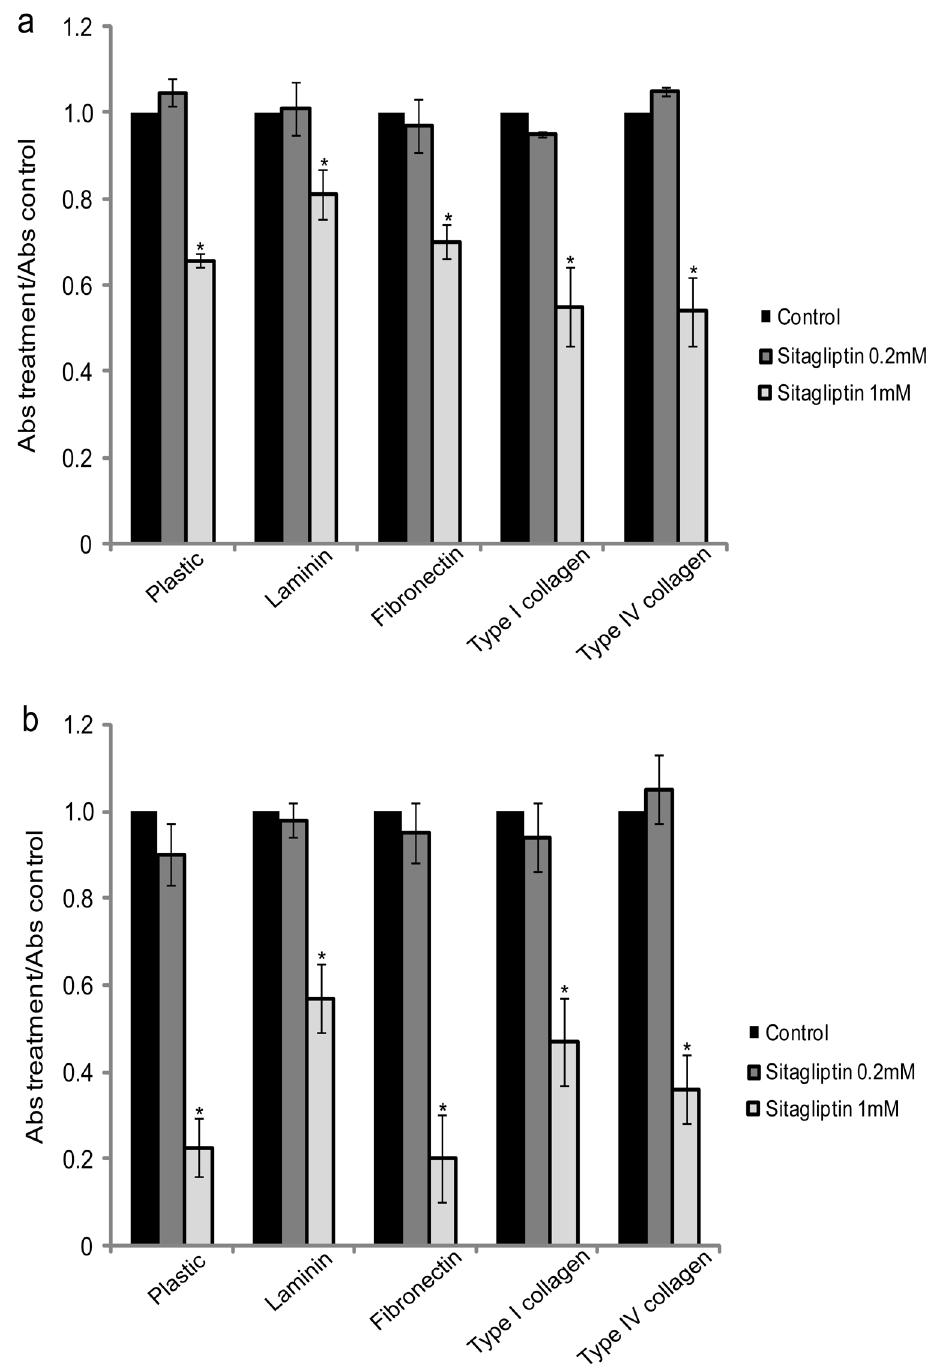
Fig 5. Effect of sitagliptin phosphate on cell adhesion. Comparison of the adhesion on plastic plates uncoated or coated with ECM proteins (laminin, fibronectin, type I collagen and type IV collagen), of cervical cancer cells SiHa (a) and HeLa (b) 2 h after plating in the absence (control) and presence of 0.2 or 1 mM sitagliptin phosphate. Data were presented as the ratio of treatment absorbance/control absorbance. Results are mean values ± SD (n = 3). * Indicates statistical significance when sitagliptin phosphate groups were compared to the respective control group. (ANOVA followed by Tukey ’ s test, p (cid:1) 0.05).